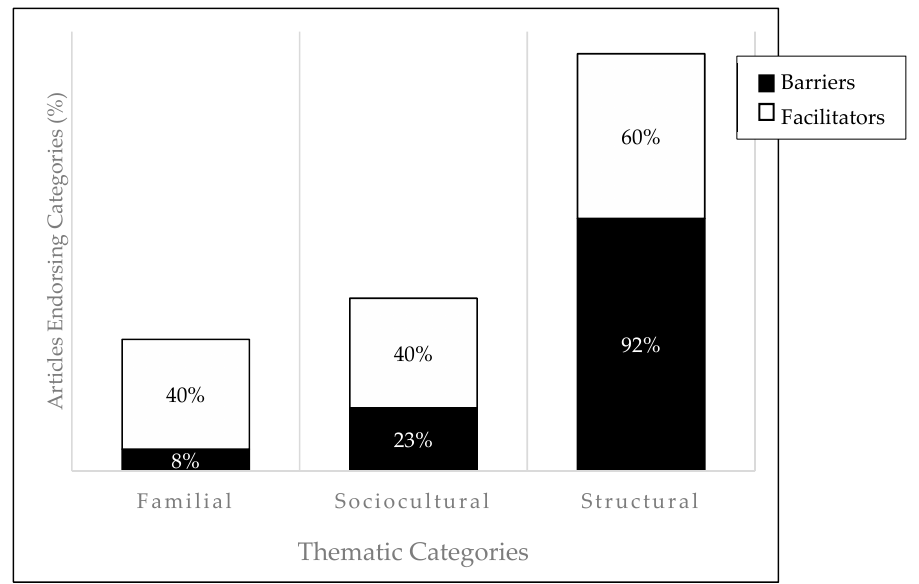
Figure 2. Percentages of review articles’ results categorized into each thematic category. Note: Group percentages do not sum to 100% as articles included in the review could reference more than one thematic category.